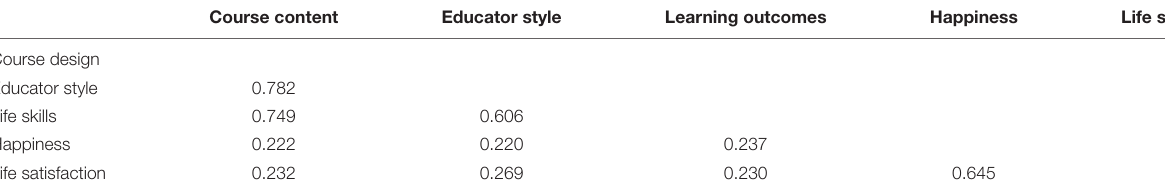
TABLE 4 | The Heterotrait-Monotrait (HTMT) Criterion Test for discriminant validity which requires values not to exceed 0.85.